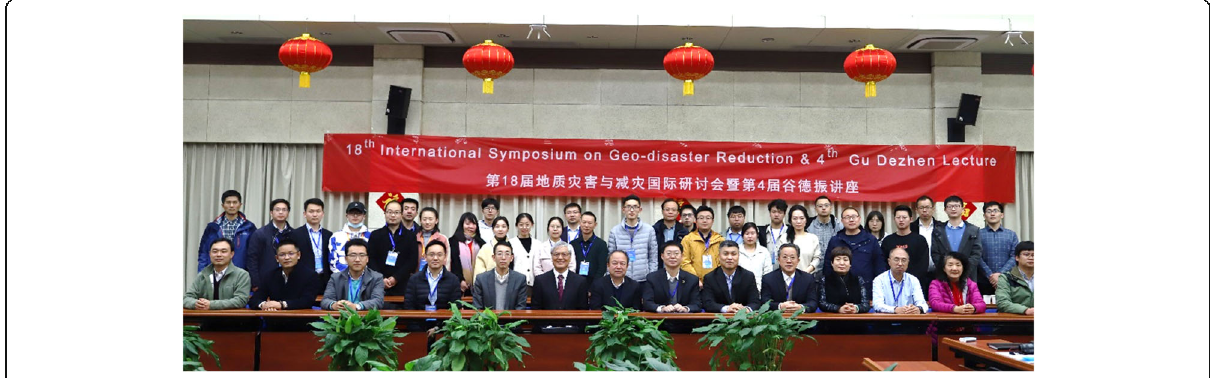
Fig. 7 Group photo of participants at the closing ceremony